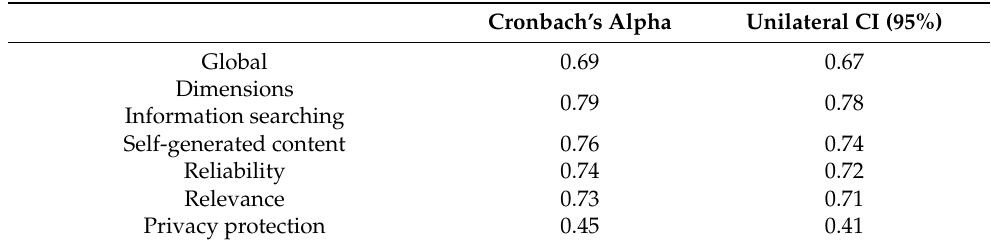
Table 2. Internal consistency of the DHLI questionnaire translated into Spanish, COVID-DHLI- Spanish ( n =